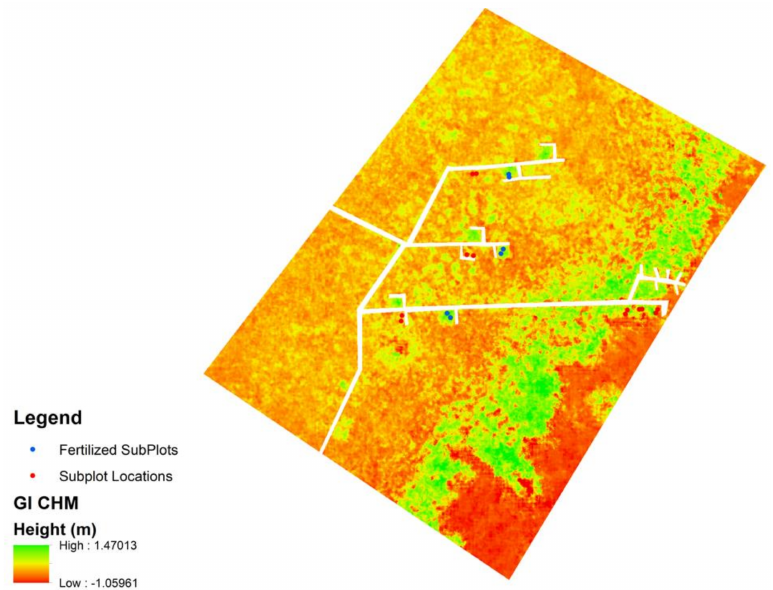
Figure 5. Example CHM for the GI site. Fertilized plots are represented by blue dots, and other non-fertilized plots are represented by red